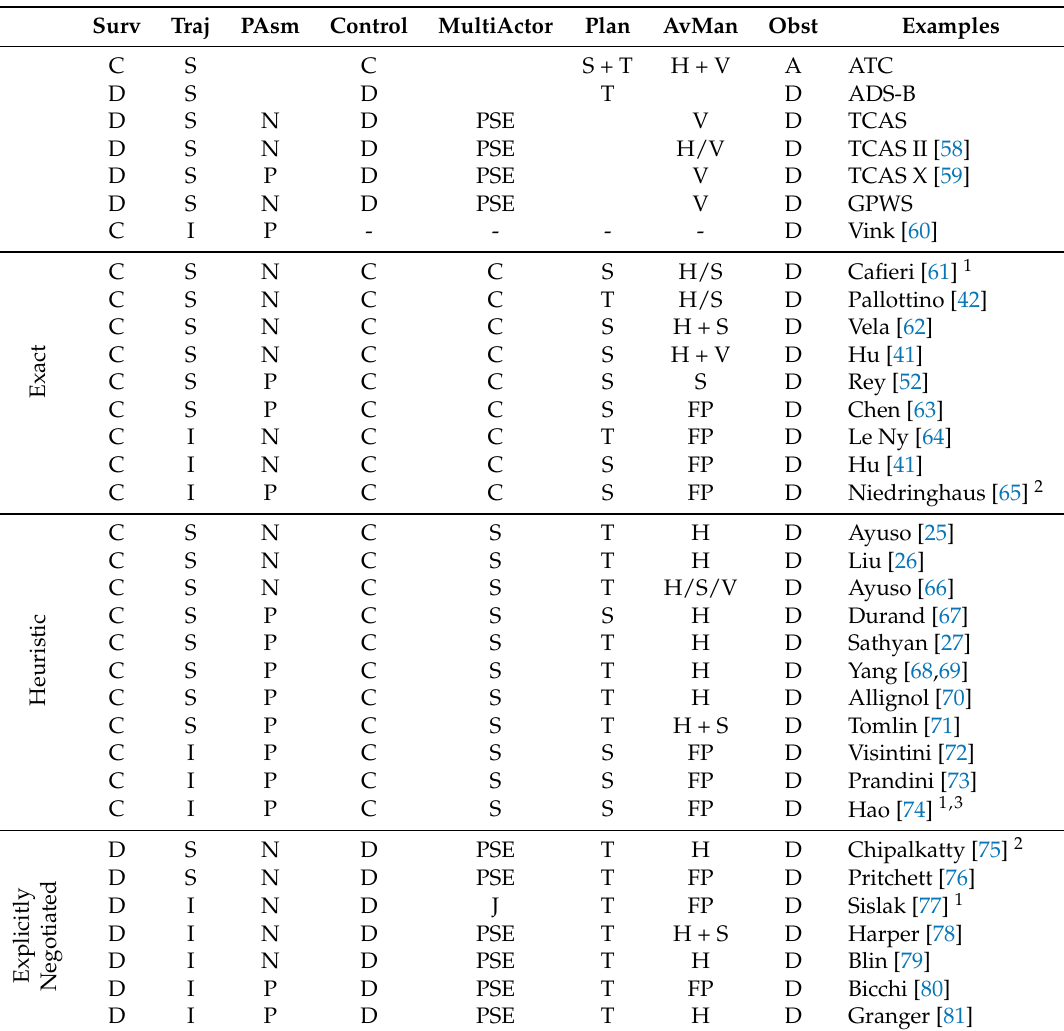
Table 3. Conflict detection and resolution methods for manned aviation. Table 5 defines the used